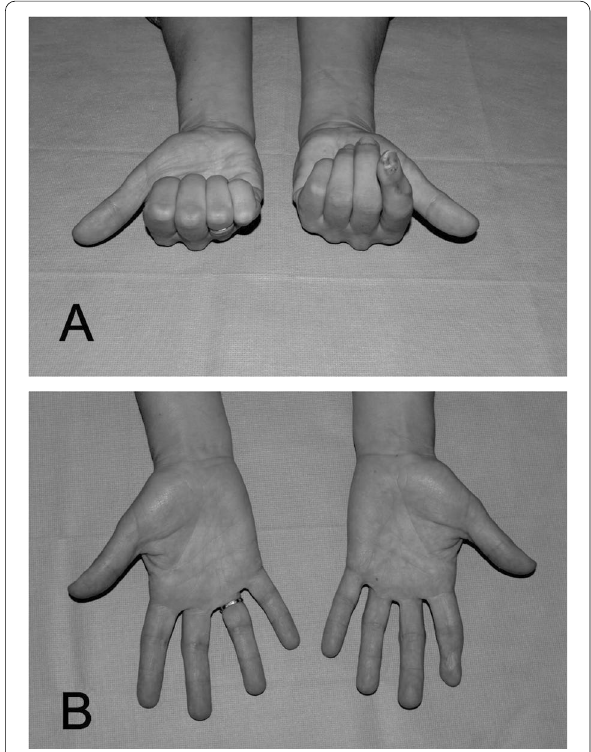
Fig. 2 Photographs showing the examination of the fingertip-to-palm distance (FPD, A ) and the fingertip-to-table distance (FTD, B